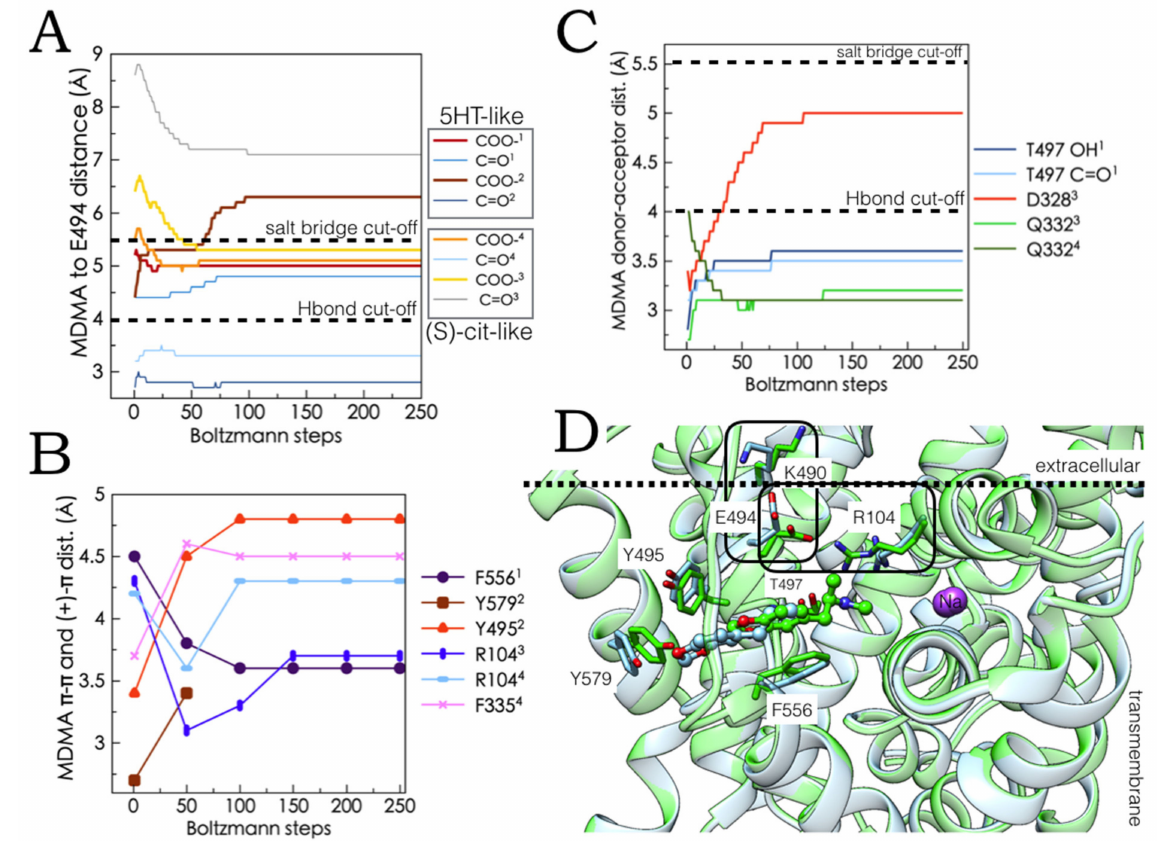
Figure 6. Ligand-protein electrostatic interactions under Monte Carlo (MC) simulations of four holo double-bound MDMA/hSERT complexes. Data correspond to either the ‘5-HT-like’ (replicas 1 and 2 in superscript) or the ‘escitalopram-like’ orientation (replicas 3 and 4 in superscript). ( A ) Interatomic distances from the cationic amine of MDMA and either the oxygen from the side chain (carboxylate) or the backbone (carbonyl) of Glu494 along the MC trajectories, as a marker of stability and occurrence of electrostatic bonds (according to the rectangles in the right-hand side of the plot). ( B ) Occurrence and stability of aromatic interactions evaluated by centroid-to-centroid distances with a 5 Å cut-off, as a function of the MC energy jumps. Data points represent allowed π interactions. ( C ) Interatomic ligand-protein H-bond/salt bridge distances as a function of the MC energy jumps ( n = 4 in a total of 1000 Boltzmann steps). ( D ) MDMA/hSERT complexes in the ‘5-HT-like’ orientation of the drug at the end of the MC simulations. Replica 1 in blue and replica 2 in green. MDMA corresponding molecules are in ball and stick representation. The residues with the most favourable interactions in this orientation are shown. The salt bridges involved in the allosteric modulation of the hSERT are black